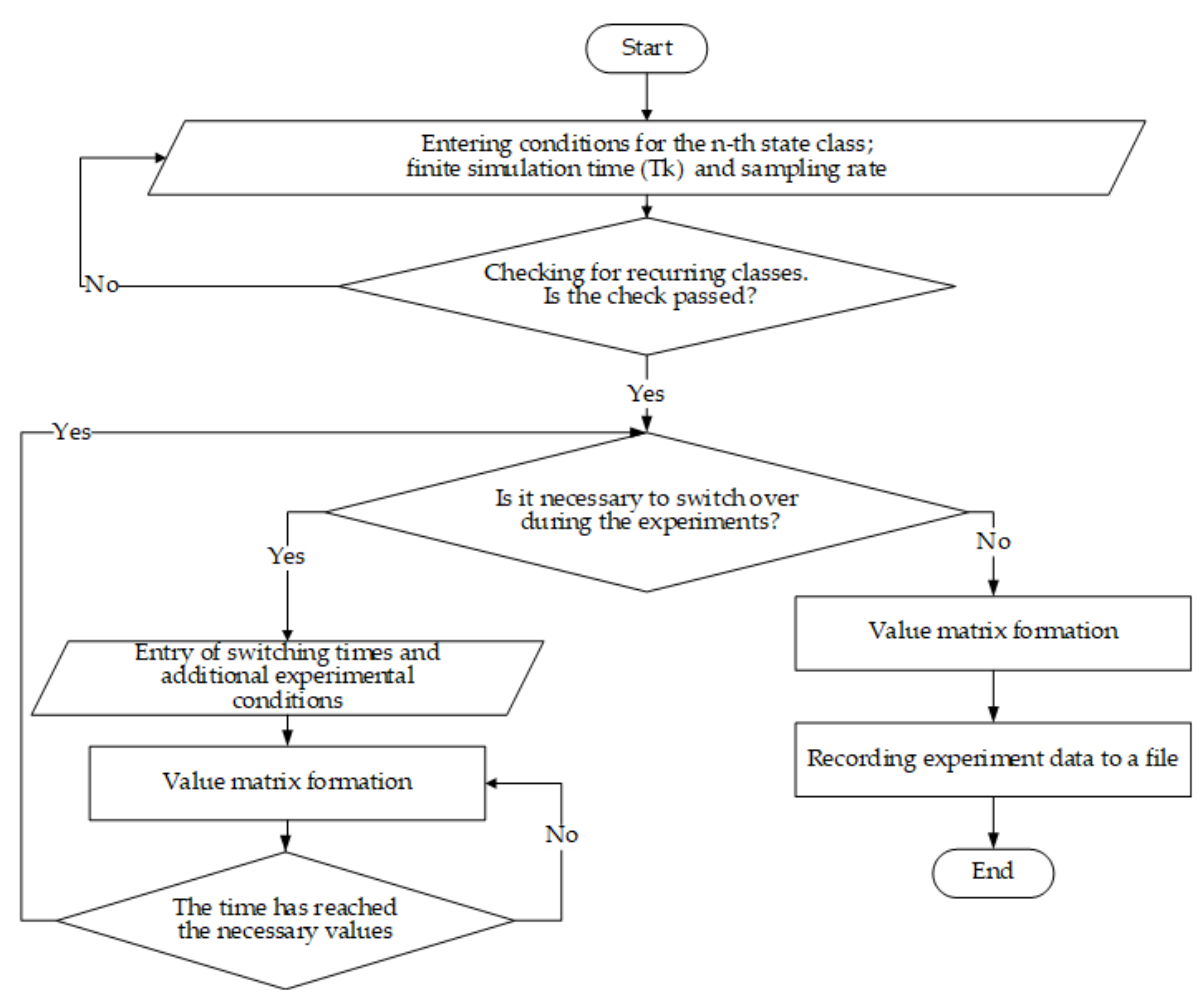
Figure 6. General algorithm for conducting experiments.